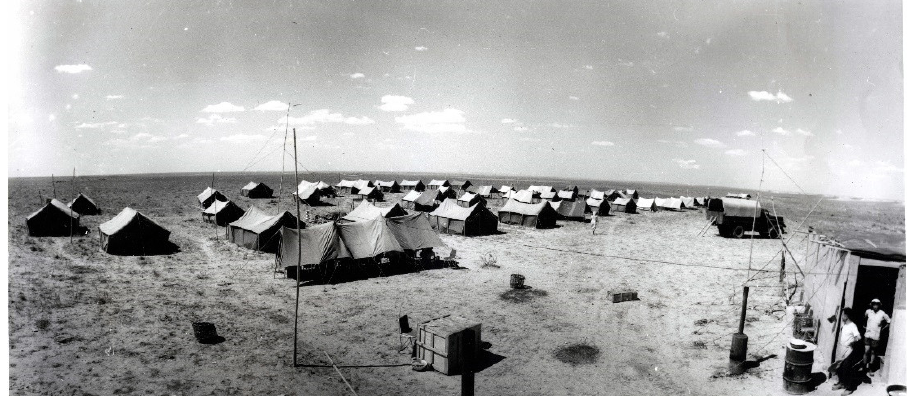
Figure 5. Field camp of the Sino–Soviet Union joint expedition in Inner Mongolia in 1959 (credit to IVPP).